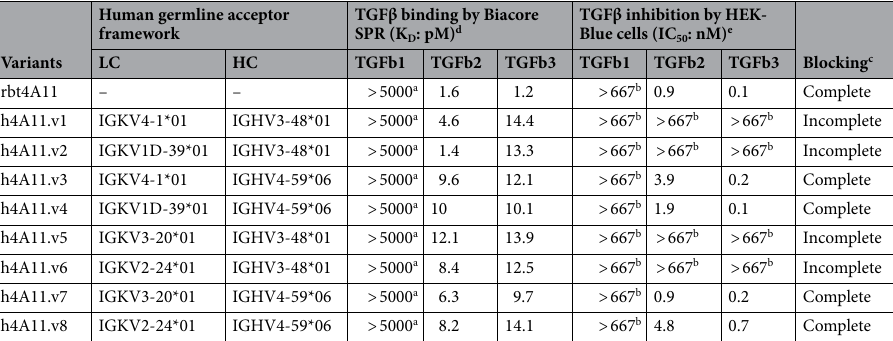
Table 1. Functional characterization of primary humanized 4A11 variants. a The binding was not observed at the highest TGFβ1 concentration (5 nM); therefore, the reported KD are lower limits. b The maximun inhibition did not achieve over 90% at the highest antibody concentration (667 nM); therefore, the reported IC50 are lower limits. c The complete blocking or incomplete blocking was defined by TGFβ2 and TGFβ3 inhibition greater than 90% or less than 70%, respectively, at the highest antibody concentration. d The affinity constant (K D ) for each variant is calculated using a global fitting model and reported as a single value for the whole data set with an average fitting standard error of 10%. e The half-maximal inhibitory concentration (IC 50 ) for each variant from quadruplicate experiments is calculated using nonlinear regression with a four- parameter variable slope curve fit and reported as a single value with an average fitting standard error of